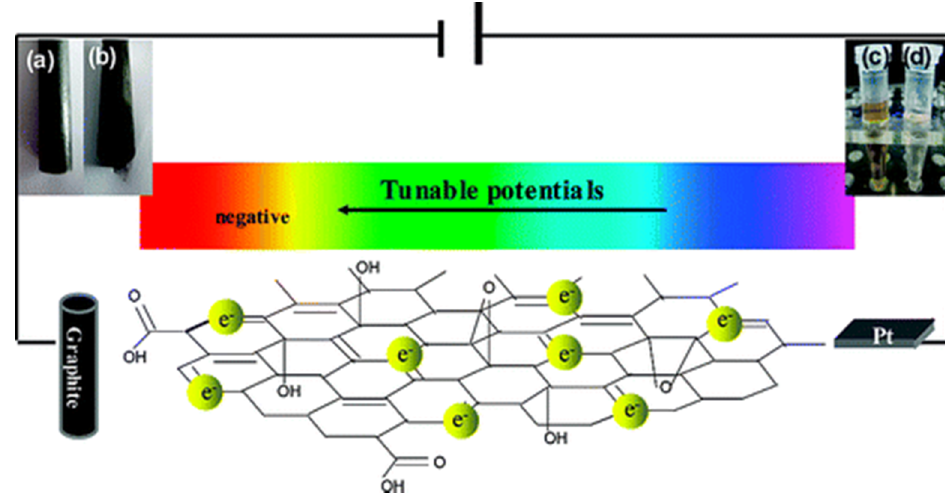
Figure 8. ( a , c )Optical illustration of graphite electrode and GO suspension before and ( b , d ) after reduction. “Reproduced with permission from [97], [ACS Nano]; published by [American Chemical Society], 2009”.